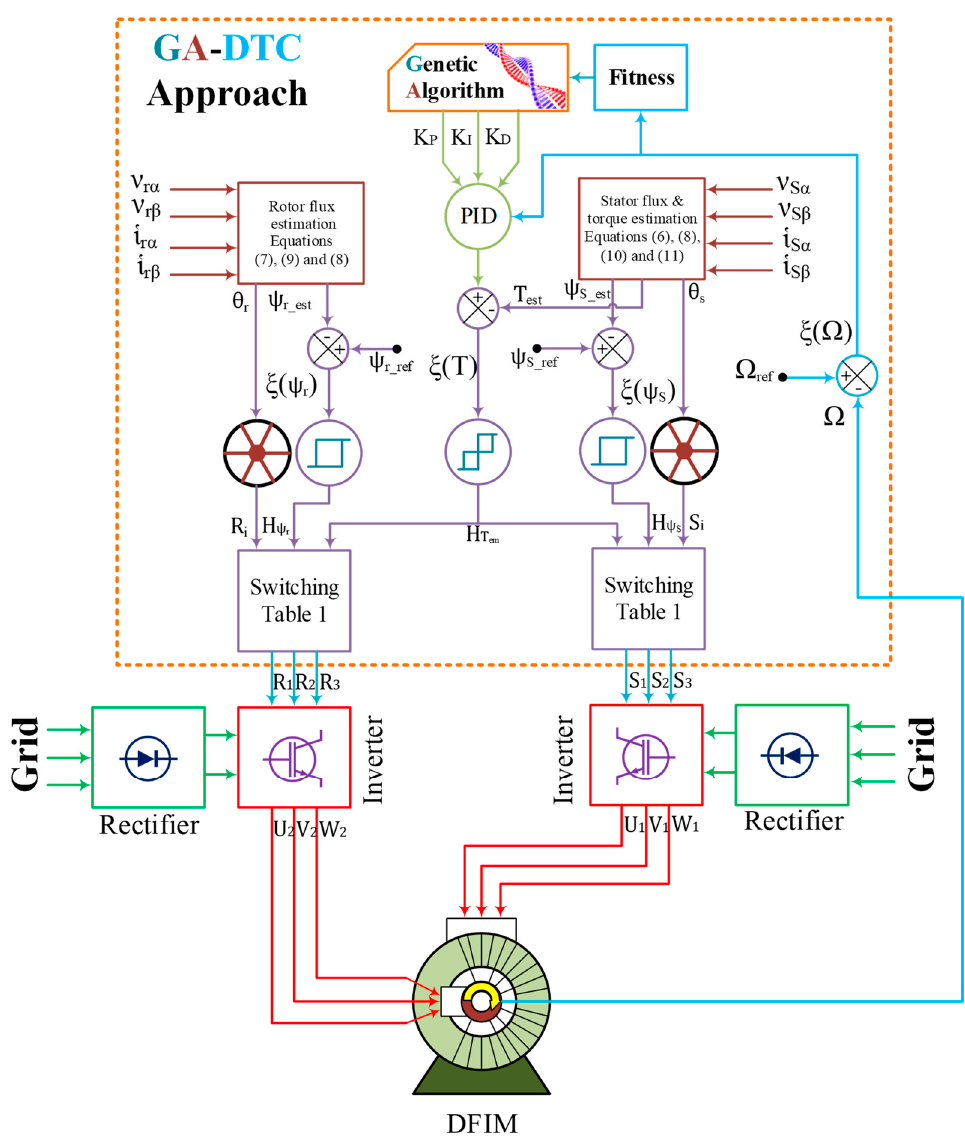
Figure 5. GA–DTC schematic applied to a DFIM.